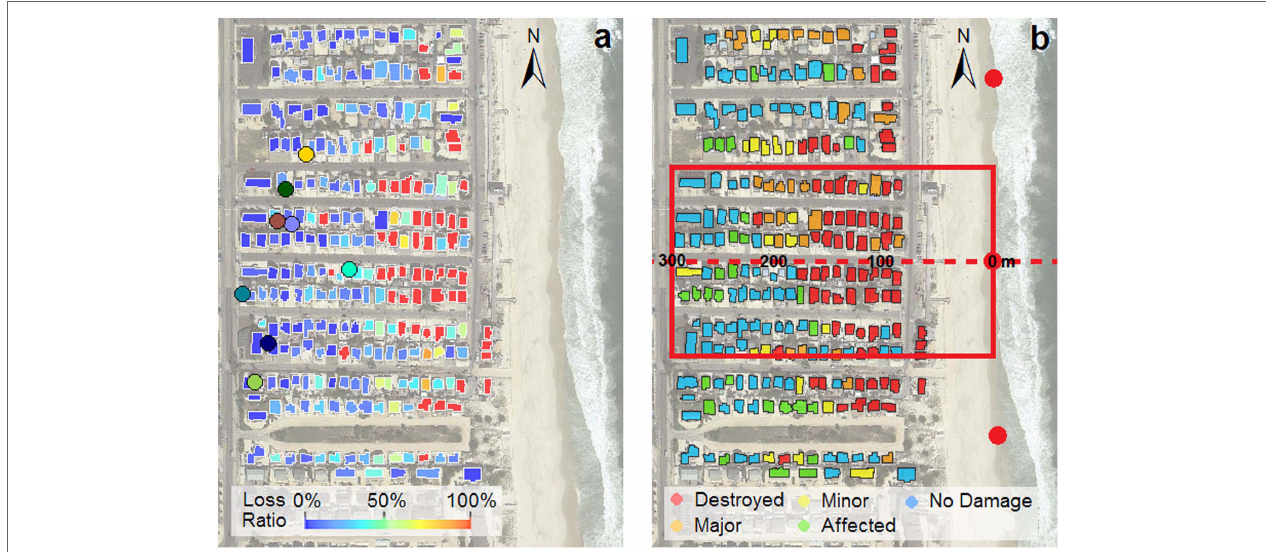
FIGURE 2 | Plan view of Ortley Beach, NJ with polygons representing surveyed structures colored based on their (A) estimated loss ratio from Xian et al. (2015) and (B) damage state from Federal Emergency Management Agency aerial survey. Colored circles in panel (A) represent the location of observed highwater marks. Panel (B) shows an example of the 200m (cid:2) 300m discretization and one-dimensional transect used for data collection. Red circles in panel (B) represent the center points of the 200m discretization of the coast. Distance markers along the transect in panel (B) are consistent with those shown in Figures 5 and 6 . [Panel (A) is reproduced from Hatzikyriakou and Lin